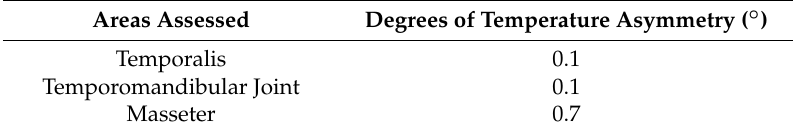
Table 1. Infrared imaging values of the thermic difference between left ‐ and right ‐ side at the first appointment.